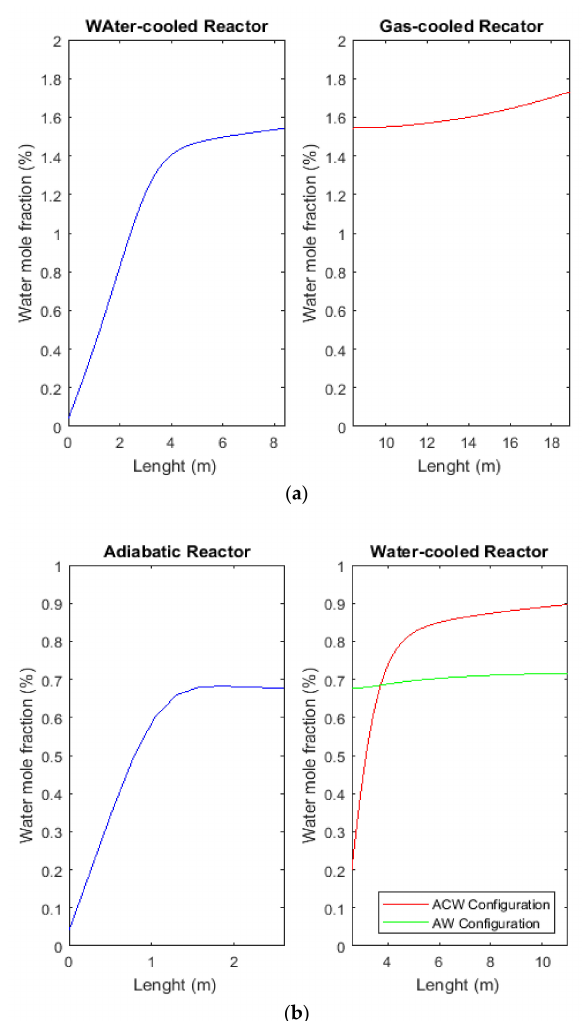
Figure 9. Water mole fraction (%) along the reactors in ( a ) CR configuration; and ( b ) AW and ACW configurations.